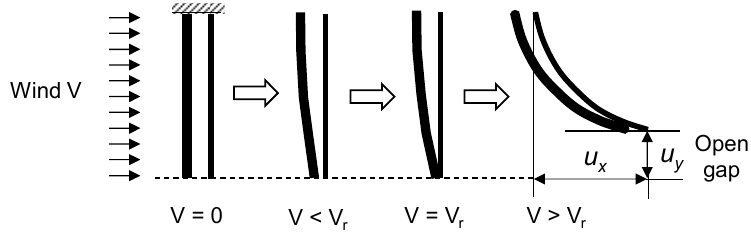
Figure 4. Illustration of the idea of a bi-cantilever flange.